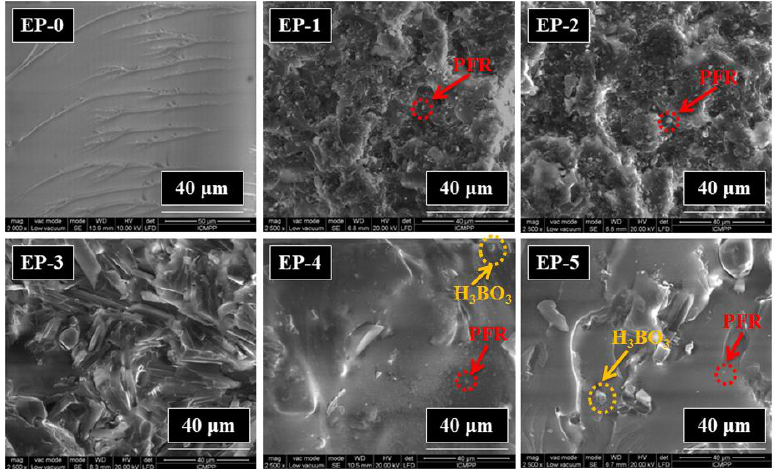
Figure 6. SEM micrographs of epoxy composite